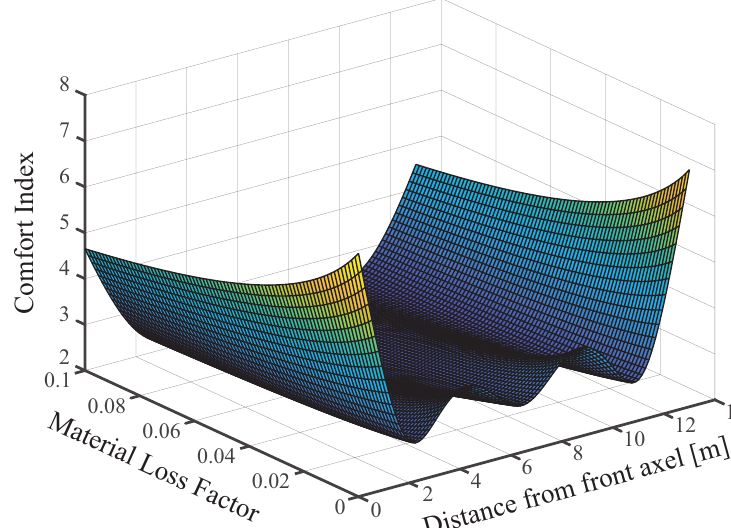
Figure 10. Comfort index along the length of the beam versus the material loss factor ( η ).